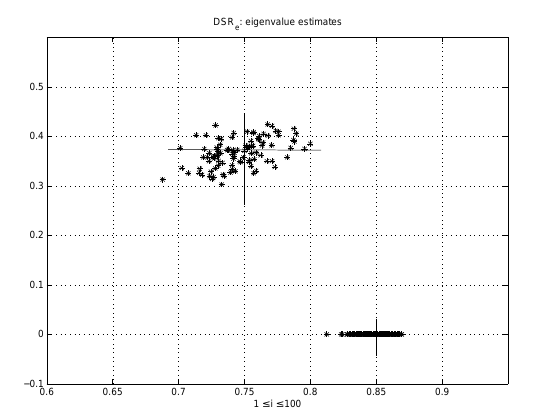
Figure 7: Eigenvalue estimates for from the DSR e method. The correct eigenvalues are λ 1 = 0 . 85 and a complex conjugate pair, λ 2 , 3 = 0 . 75 ± j 0 . 3708 . Complex eigenvalues are in complex conjugate pairs. Hence, the negative imaginary part is not presented.